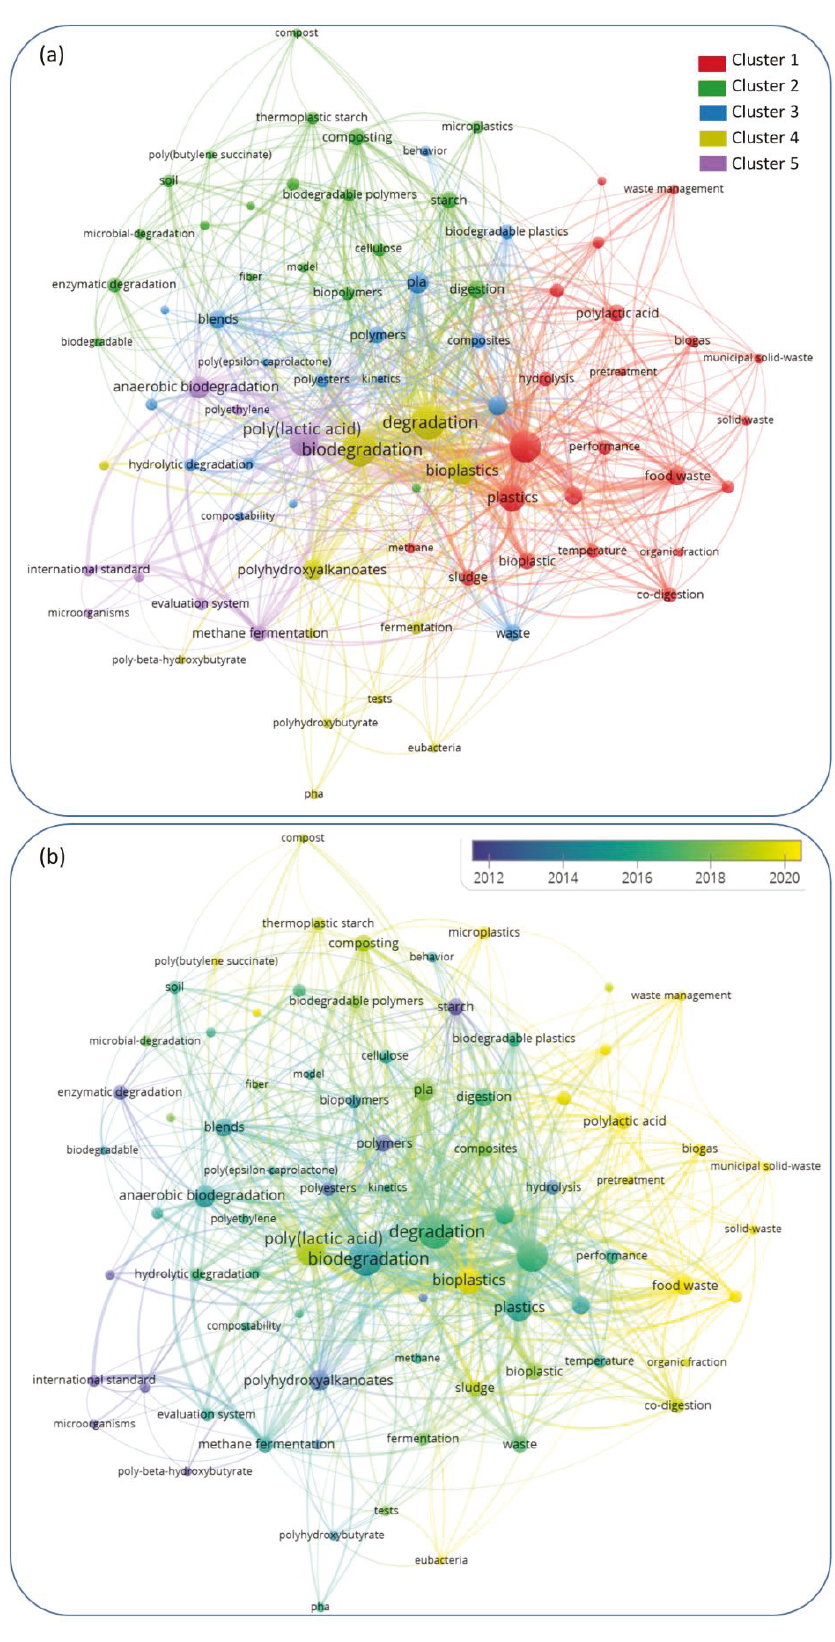
Figure 3. ( a ) Network of keyword co-occurrence and ( b ) overlay visualization of keyword co- occurrence over time built in